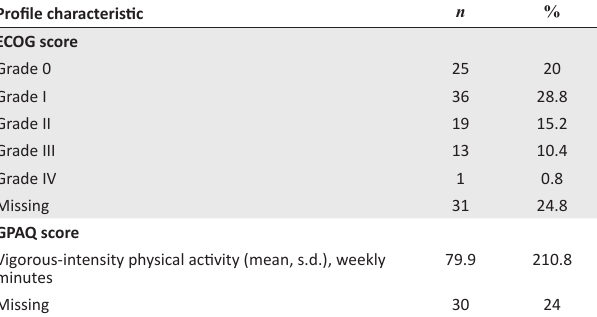
TABLE 2: Functional and physical activity profile of a South African urban cohort presenting with colorectal Ca at a private university specialist referral centre ( n =